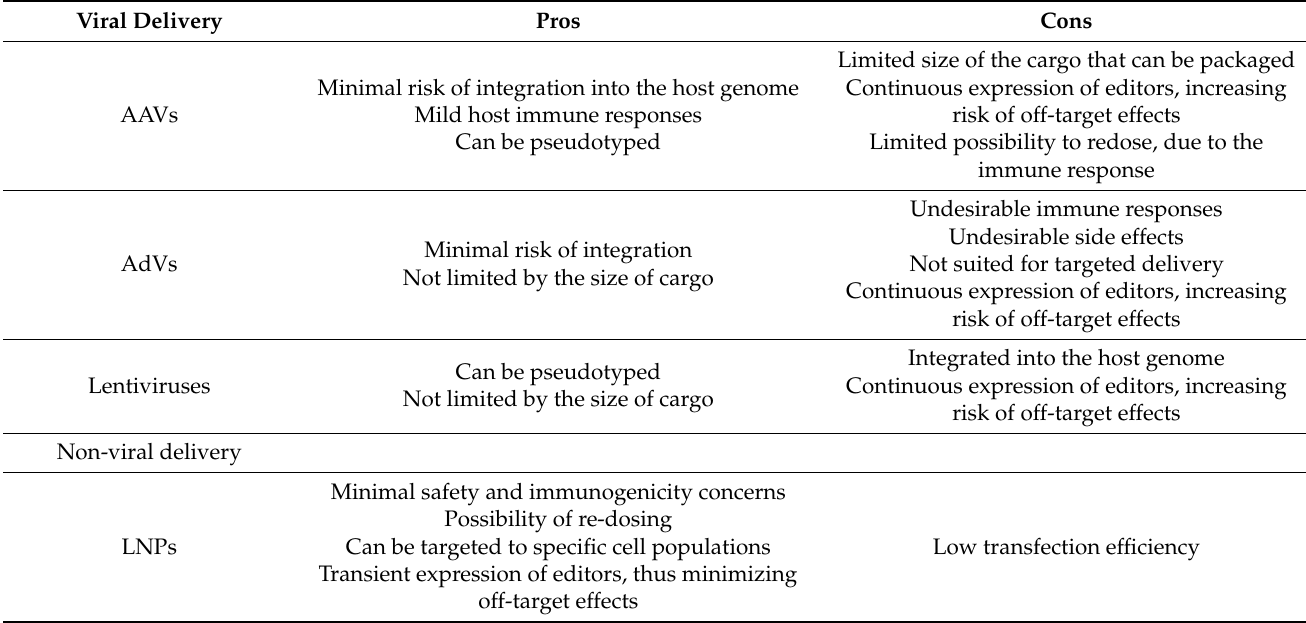
Table 2. Approaches for in vivo delivery of gene